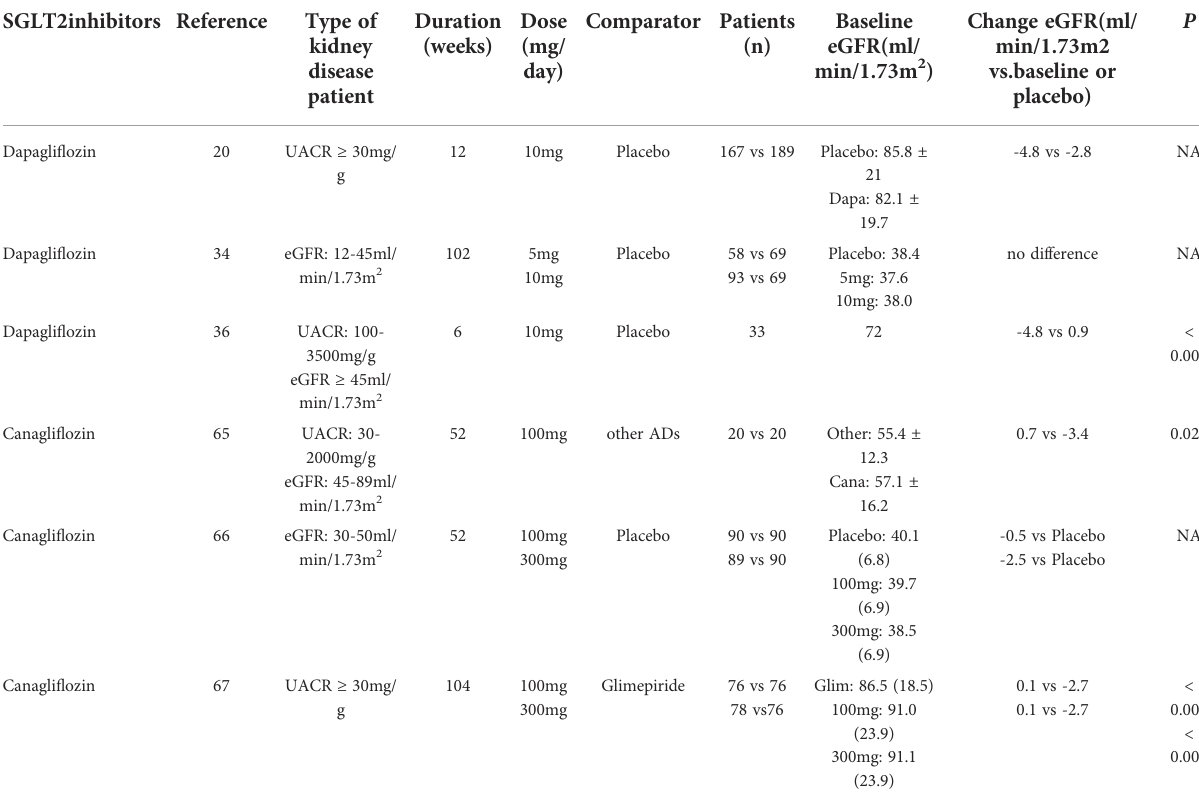
TABLE 3 Effects of Sodium-glucose cotransporters 2 (SGLT2) inhibitors on estimated glomerular fi ltration rate (eGFR) in randomized controlled trials (RCTs) in patients with type 2 diabetes and chronic kidney disease (CKD) of different levels. SGLT2inhibitors Reference